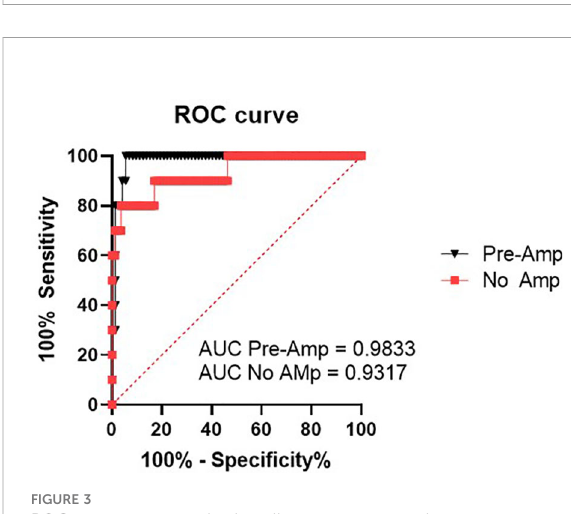
FIGURE 3 ROC curves generated using all no-recurrence values as negative samples and the endpoint known recurrence values as de fi ned by detection via standard methods (imaging/HCG,LDH, AFP), including all false negative and false positive